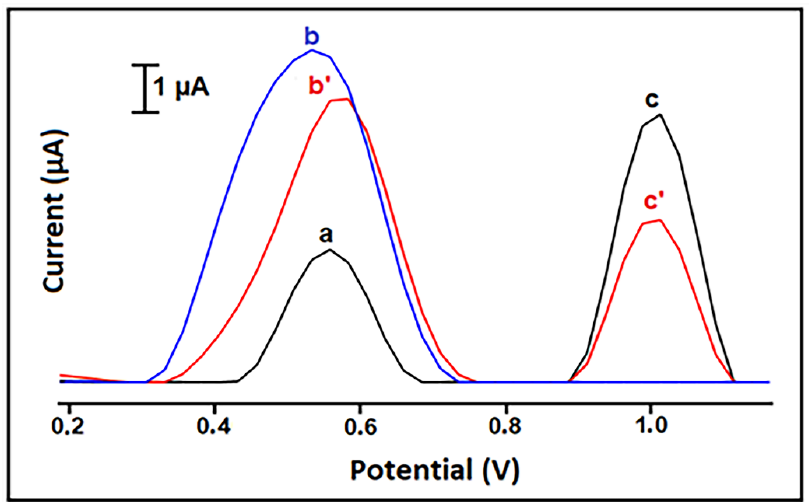
Figure 5 Figure 5. Voltammograms representing the oxidation signal of 10 µ g/mL curcumin and the oxidation signal (i.e., guanine signal) of 25 µ g/mL ctDNA measured before and after 3 min interaction: (a) the control signal measured by HaP-IL-PGE, oxidation signal of curcumin (b) before, (b’) after interaction, oxidation signal of guanine (c) before, (c’) after interaction.